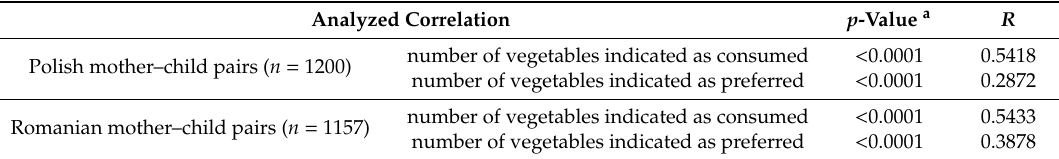
Table 2. Analysis of the correlation between the number of types of vegetables indicated as consumed and preferred by mothers and by their children in nationally representative samples of Polish ( n = 1200) and Romanian ( n = 1157) mother–child